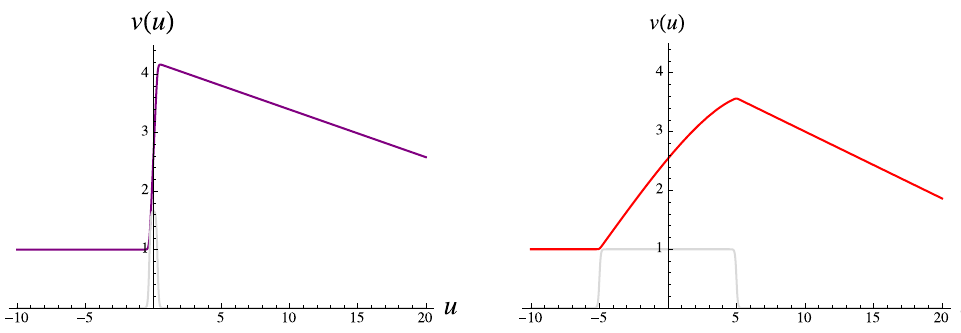
Figure 5 . The lightcone coordinate v ( u ) of a test particle exhibits a jump as it encounters the gravitational wave burst, for both impulsive (left-hand (cid:12)gure) and extended (right-hand (cid:12)gure) pro(cid:12)les. Note the discontinuous (and backwards in time) jump in the impulsive gravitational shockwave